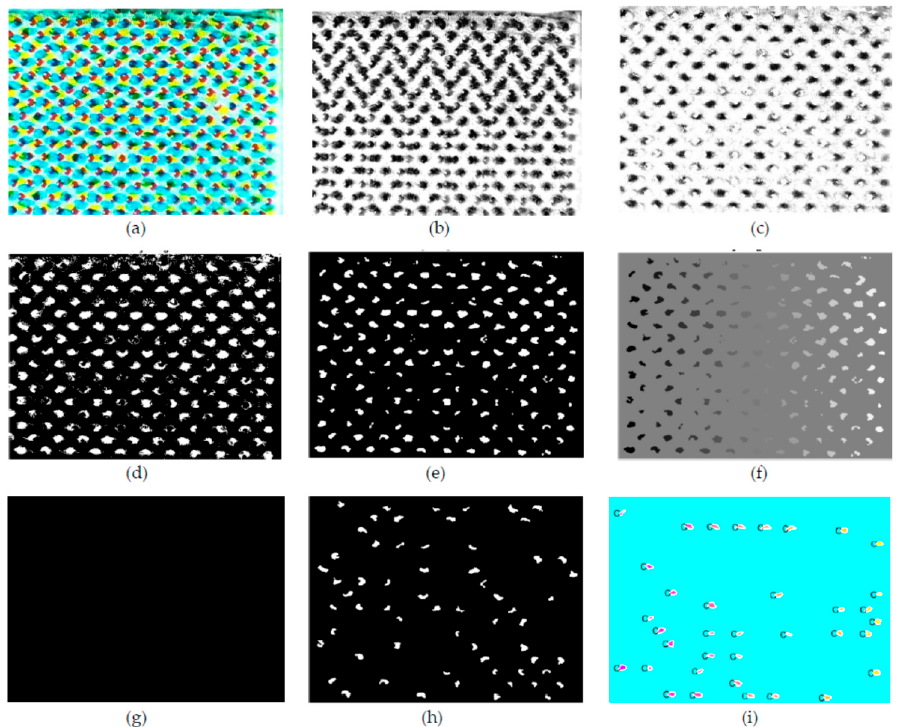
Figure 9. Illustration of the results obtained step by step. In this example yellow dots are extracted, measured and analyzed. ( a ) CMY image, ( b ) Step 1: extraction of the Yellow channel, ( c ) Step 1: Y image after removal of Magenta shadow, ( d ) Step 2: binarization, ( e ) Steps 3.1 to 3.4: removal of noise and irrelevant areas, ( f ) Step 4: labelling of regions of interest, ( g ) Step 5: removal of outliers, ( h ) Step 7: extraction of dots with concavity ( ∈ ID1/ID2/ID3) or an irregular shape ( ∈ ID4) defined by a solidity upper than 0.75, ( i ): extraction of dots with a convex shape ( ∈ ID5) with a circular equivalent shape, or an elliptic equivalent shape, or another pattern